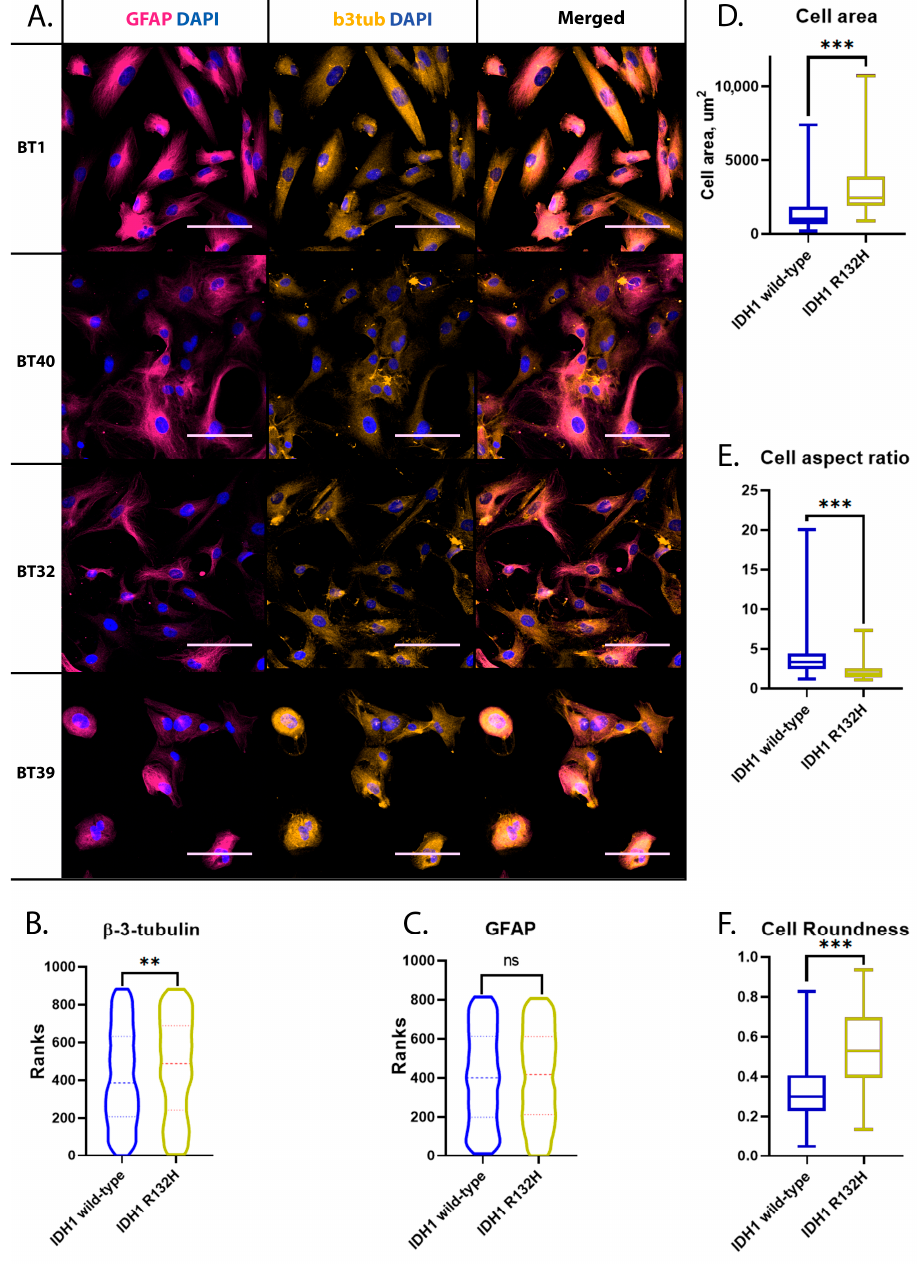
Figure 1. Immunocytochemical and morphological characterization of obtained glioma early ‐ passage cell cultures. Asterisks indicate level of statistical significance: ** p ≤ 0.01, *** p ≤ 0.001 and “ns” p > 0.05. ( A ) GFAP and beta ‐ 3 ‐ tubulin immunostaining. Scale bar is 100 um. ( B ) Beta ‐ 3 ‐ tubulin labeling intensity comparison in IDH1 wild ‐ type and IDH1 R132H mutant early ‐ passage cell cultures. ( C ) GFAP labeling intensity comparison in IDH1 wild ‐ type and IDH1 R132H mutant early ‐ passage cell cultures ( D ) Surface area comparison of IDH1 wild ‐ type and IDH1 R132H cell cultures. ( E ) IDH1 wild ‐ type and IDH1 R132H cell aspect ratio comparison. ( F ) Cell roundness of IDH1 wild ‐ type and IDH1 R132H cultures.